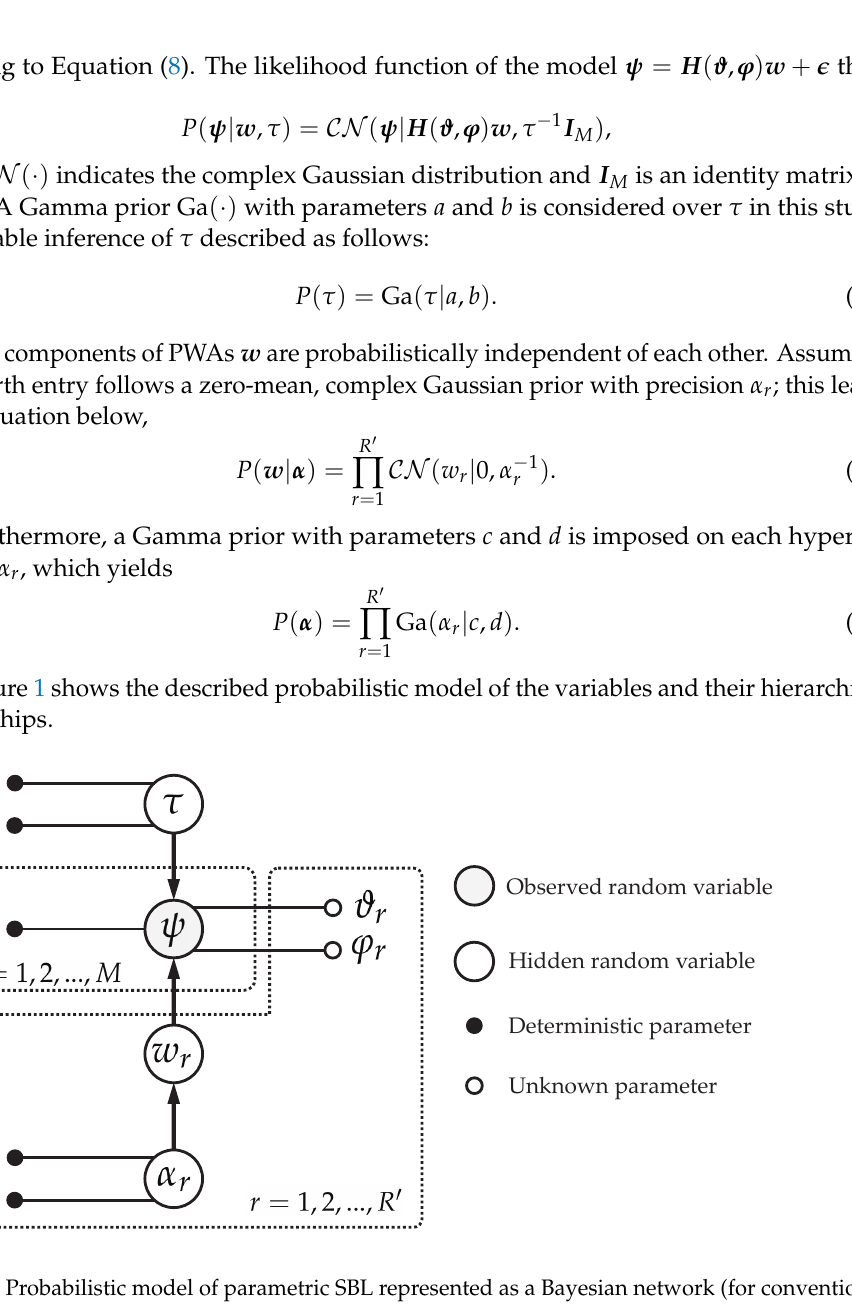
Figure 1. Probabilistic model of parametric SBL represented as a Bayesian network (for conventional SBL, the parameters a , b , c , and d , are often set to be very small values, such as 10 − 6 , in this